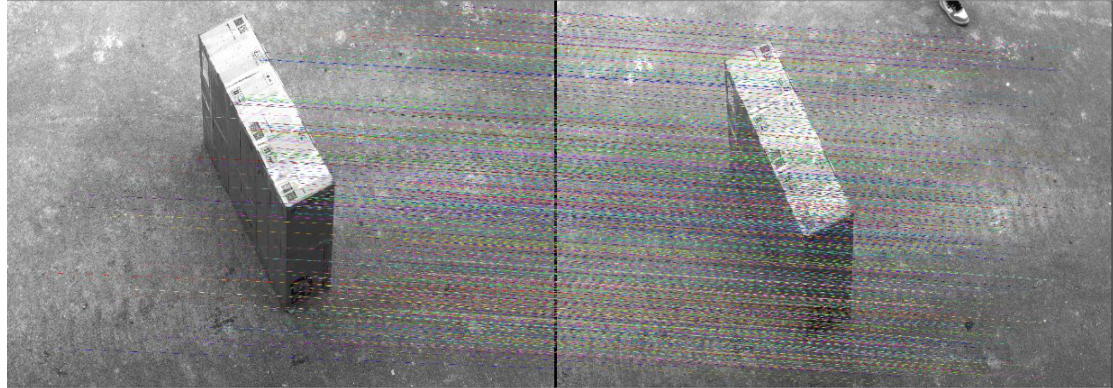
Figure 4. Image 1 matching numbers based on siftGPU.